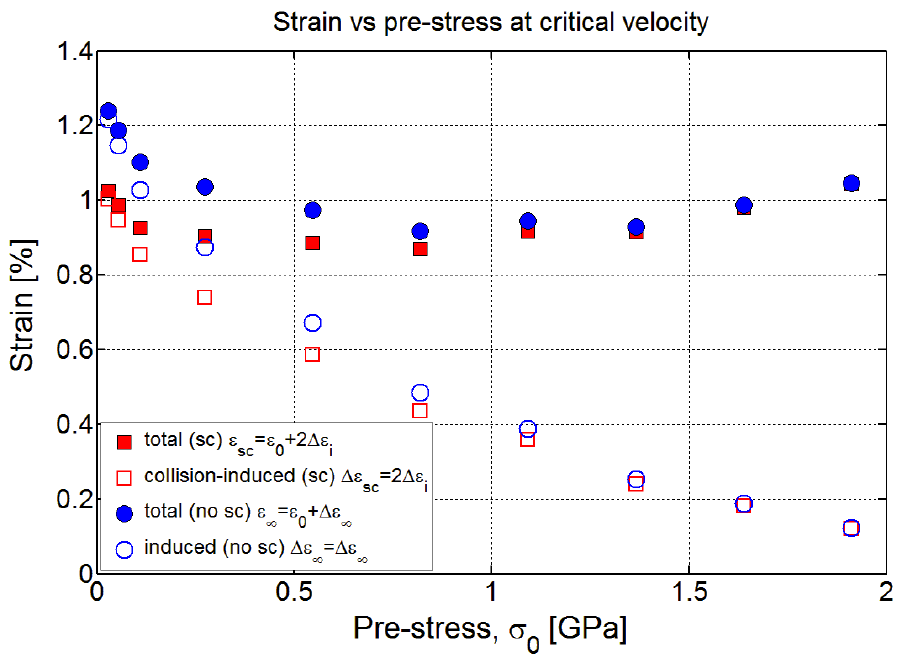
Figure 13. Calculated strength versus pre-stress and critical velocity for the two projectile types.